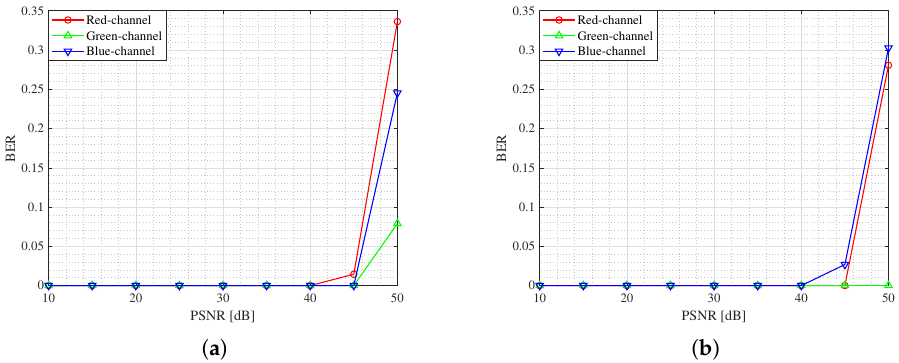
Figure 22. BER performance according to PSNR for standard images ( a ) Baboon. ( b )